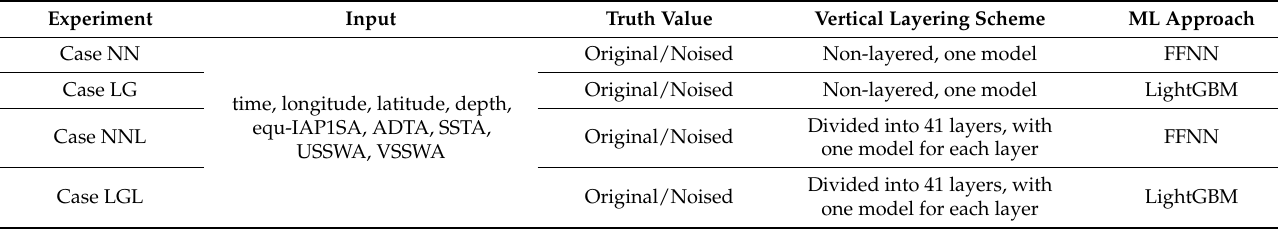
Table 1. Experimental